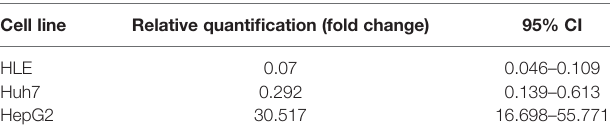
Data indicate the fold